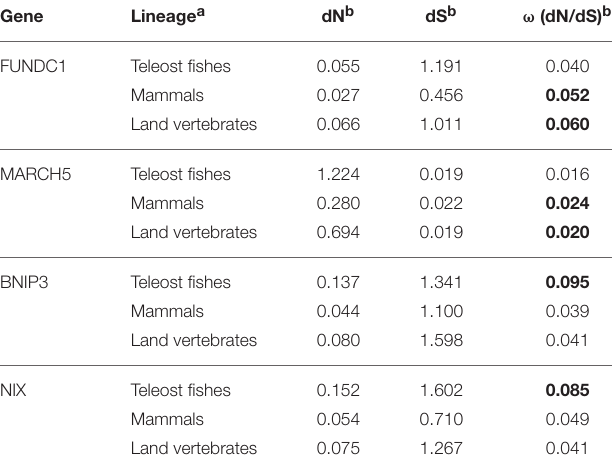
TABLE 4 | Estimation of substitution rate variation on domains of FUNDC1 and MARCH5 in the lineages of teleost fishes, mammals and land vertebrates. Gene Domain